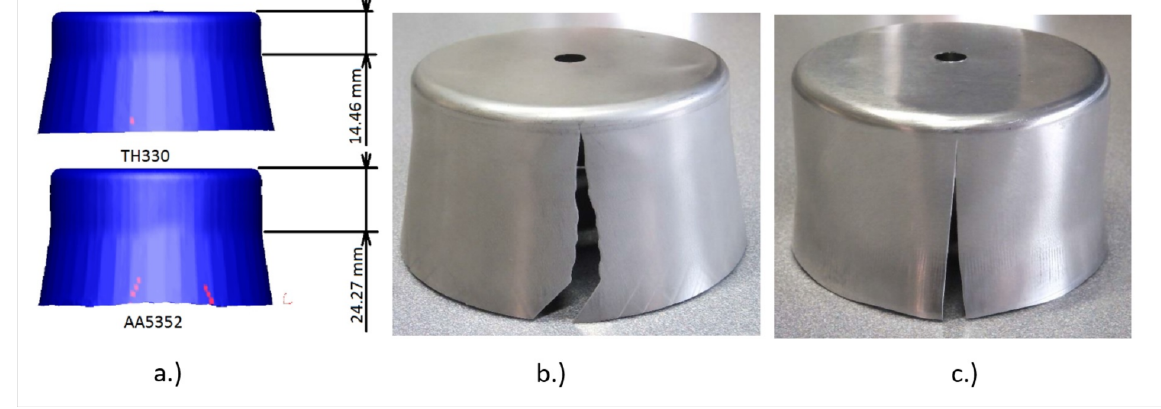
Figure 10: Expansion punch stroke at the moment of failure occurred (a.), drawn cups with failure of TH330 (b.) [19] and AA5352 (c.) [19]